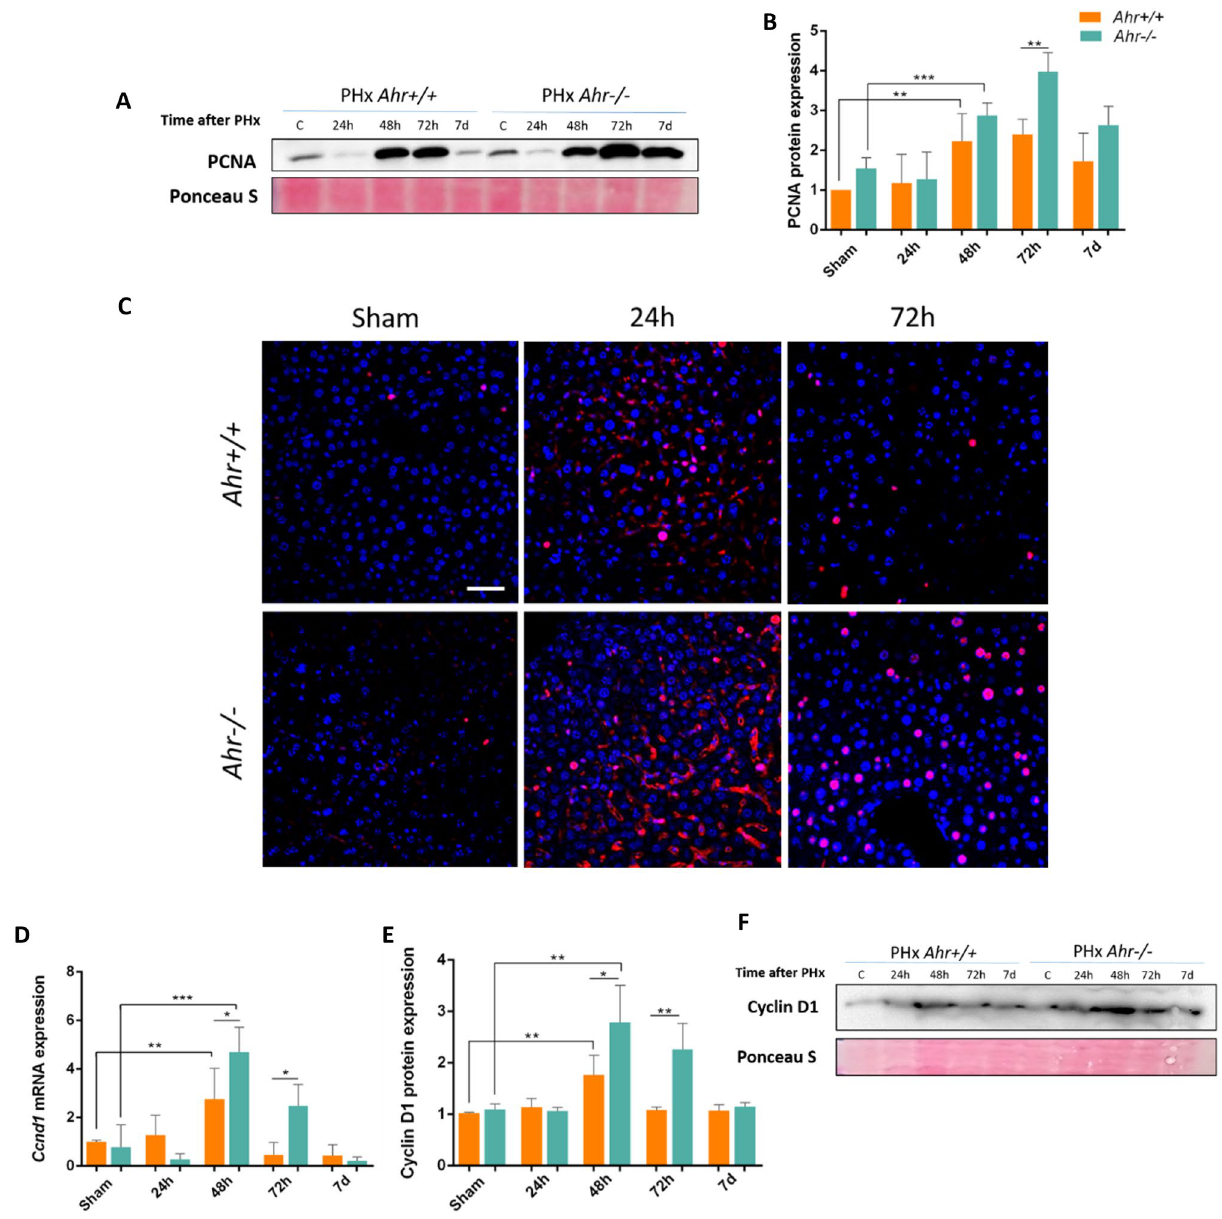
Figure 2. Proliferation rates are increased in the livers of Ahr −/− mice after PHx. ( A – C ) Protein expression of PCNA was determined by immunoblotting ( A , B ) and immunofluorescence ( C ) in liver extracts of Ahr + / + and Ahr −/− mice at the indicated time points after PHx. Cyclin D1 expression was also analyzed at the mRNA level by quantifying Ccnd1 by RT-qPCR ( D ) and at the protein level by immunoblotting ( E , F ) under the same experimental conditions. Ponceau staining was used to normalize protein levels. Gapdh was used to normalize target gene expression (ΔCt) and 2 −ΔΔCt to calculate changes in mRNA levels with respect to sham-surgery mice. Hoechst was used for staining cell nuclei. An Olympus FV1000 confocal microscope and the FV10 software (Olympus) were used for the analysis. Scale bar corresponds to 20 μm. *p < 0.05, **p < 0.01, ***p < 0.001. Data are shown as mean ± SD. The experiments were performed using three mice per time point and three technical replicates were done. Oligonucleotides and antibodies used are indicated in Supplementary Tables 1 and 3,